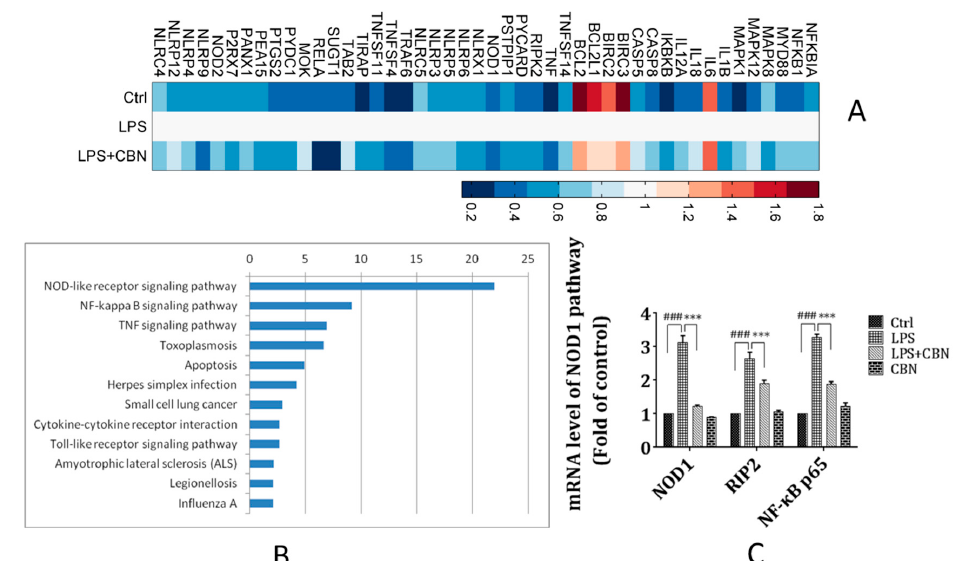
Figure 2. A PCR array detected that NOD1 was the main pathway affected by CBN in LPS-mediated inflammation. ( A ) The cluster analysis showed 84 inflammation-related genes were enriched after CBN treatment. Different colors indicate the fold change compared to β -actin (fold change > 1.5). Heatmap color intensity depicts the multiple of gene up- (41 genes) and downregulation (5 genes). ( B ) Pathway analysis of differentially expressed genes in the Kyoto Encyclopedia of Genes and Genomes (KEGG) database. Differentially expressed genes were mainly concentrated in nucleotide-binding oligomerization domain (NOD)-like receptor signaling pathways and demonstrated the highest enrichment score. The bar plot “-Log 10 ( P -value)” refers to the enrichment score of the significant enrichment pathways. ( C ) CBN inhibited LPS-stimulated NOD1/RIP2/NF- κ B p65 pathway gene expression. ### P < 0.001 versus control group; *** P < 0.001 versus LPS group. The results shown are representative of three independent experiments with similar results. Data are expressed as means ±